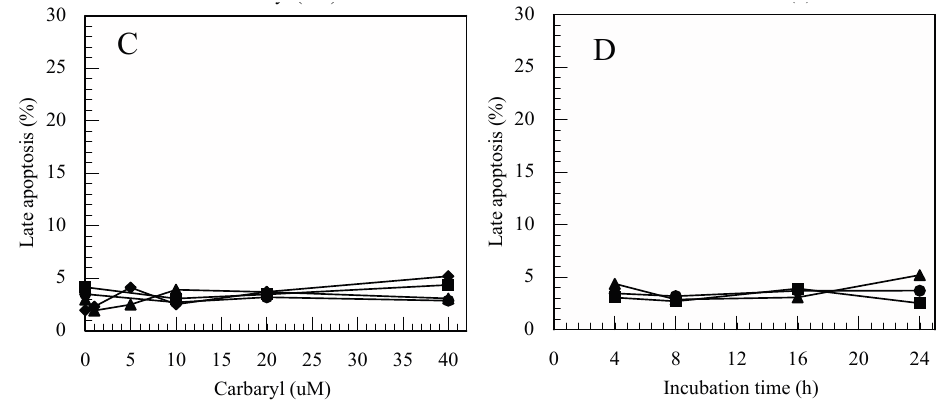
Figure 3. Carbaryl induced apoptosis in Jurkat T cells. ( A ): dose-dependent increases in